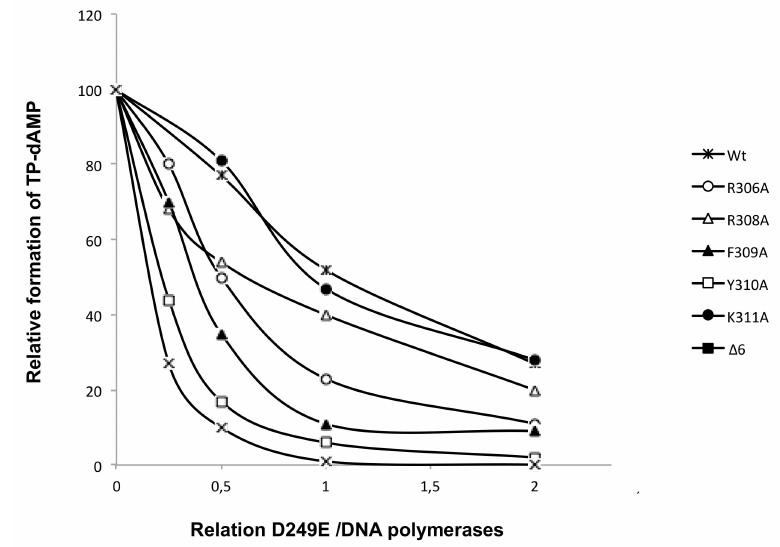
Figure 7. Competition for TP between D249E [25] and DNA polymerase mutants. The assay of formation of TP-dAMP was performed, as described in Materials and Methods, in the presence of a limited amount of TP, a fixed amount of wild-type and mutant DNA polymerase, and increasing amounts of the DNA polymerase mutant D249E. Reactions were started by adding 1 mM MnCl 2 , and after incubation for three hours at 30 ◦ C, were stopped and analyzed as indicated for the protein-primed initiation assay. The TP-dAMP formed in the di ff erent competition conditions relative to that formed in the absence of competition (100%) is